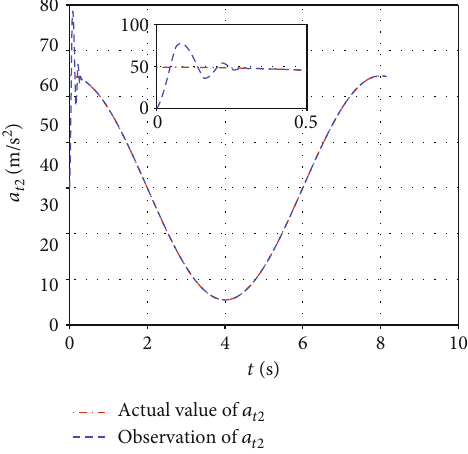
Figure 46: Direction angles φ .